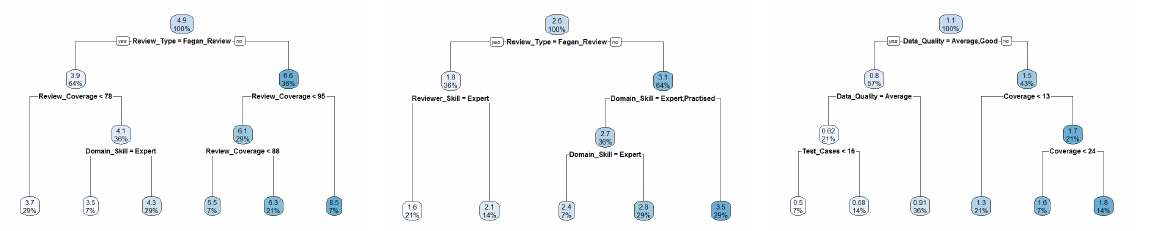
Fig. 1. cp versus cross-valida- tion error plot for design review defect density (DR DD) model